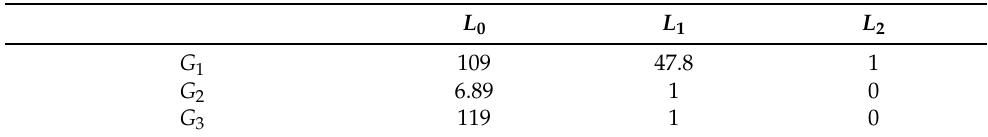
Table 2. The population ratio of each label ( L 1 , L 2 , and L 3 ) of three different evaluation groups, i.e., G 1 , G 2 , and G 3